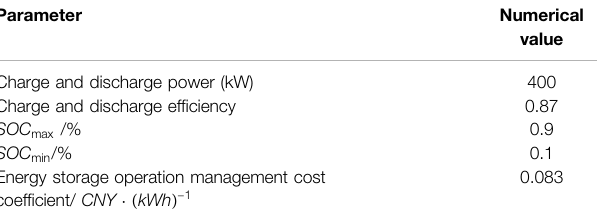
TABLE 4 | Partly parameters of the energy storage